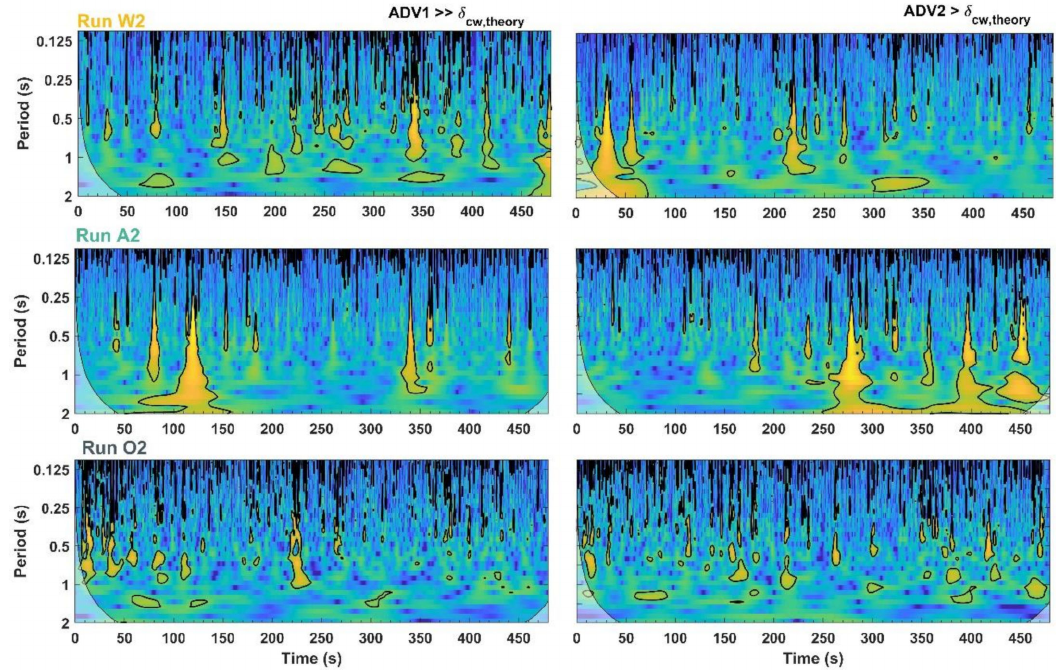
Figure 7. Continuous wavelet transforms (CWT) of the instantaneous turbulent momentum flux (Reynolds stress u (cid:48) w (cid:48) in the stream-wise vertical plane), measured at two elevations: ADV1 (higher) and ADV2 (lower), located outside the theoretical thickness of the oscillatory boundary layer δ cw,theory ; for exemplary runs W1 (waves-only); A2 (current aligned with waves); and O2 (current opposing wave). In each panel, the warmer colours (yellows) indicate higher spectral power (variance); the white shaded region represents the cone of influence, and the thicker, black contour lines delimit the 95% confidence limits (5% significance against red noise given by a Monte Carlo simulation). The y-axes defines the frequency scales of turbulent momentum exchanges in the streamwise-vertical plane, represented here as periods (inverse frequency) for